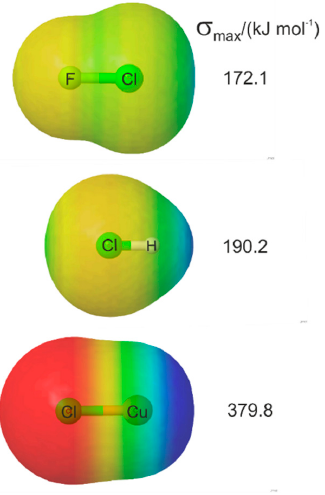
Figure 4. MESPs drawn at the 0.001 e /bohr 3 iso-surfaces of (a) ClF, (b) HCl, and (CuCl), calculated at the MP2/aug-cc-pVTZ level of theory. Dark blue represents the most positive potential, and this clearly increases dramatically from ClF to HCl to CuCl. The numerical values of the maximum positive electrostatic potentials at the iso-surface, along the molecular axis, are shown.